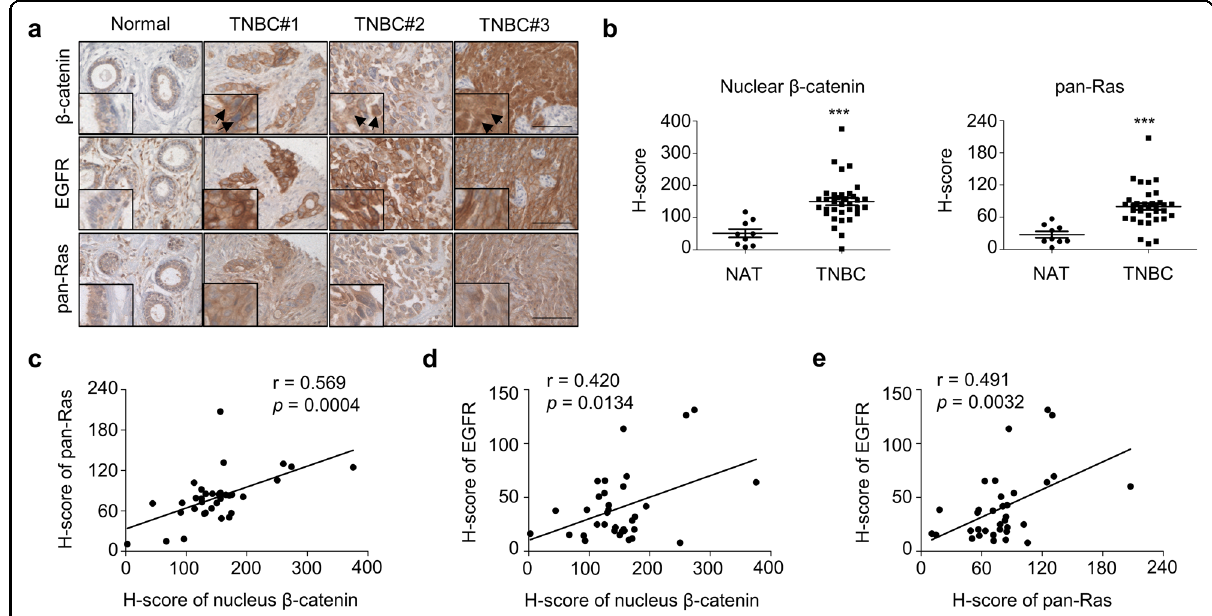
Fig. 1 The increased expression and correlation of β -catenin, pan-RAS, and EGFR in the tumor tissues of TNBC patients. a IHC analyses of the TMA including TNBC tissues ( n = 34) and NATs ( n = 10) were performed using β -catenin, pan-RAS, or EGFR antibodies. Scale bar represents 200 μ m. b Quanti fi ed H-score of nuclear β -catenin ( p < 0.0005) and cytosolic and membranous pan-RAS ( p < 0.0005) in NATs and TNBC tissues. (GraphPad Prism 5, t test with two-tailed p -value) c A positive correlation ( p = 0.0004; Pearson ’ s correlation coef fi cient) between the expression of nuclear β -catenin and pan-RAS in TNBC tissues. d , e A positive correlation (Pearson ’ s correlation coef fi cient) between the expression of EGFR with nuclear β -catenin ( p = 0.0134) or pan-RAS ( p = 0.0032) in TNBC tissues. * P < 0.05, ** P < 0.005, *** P <